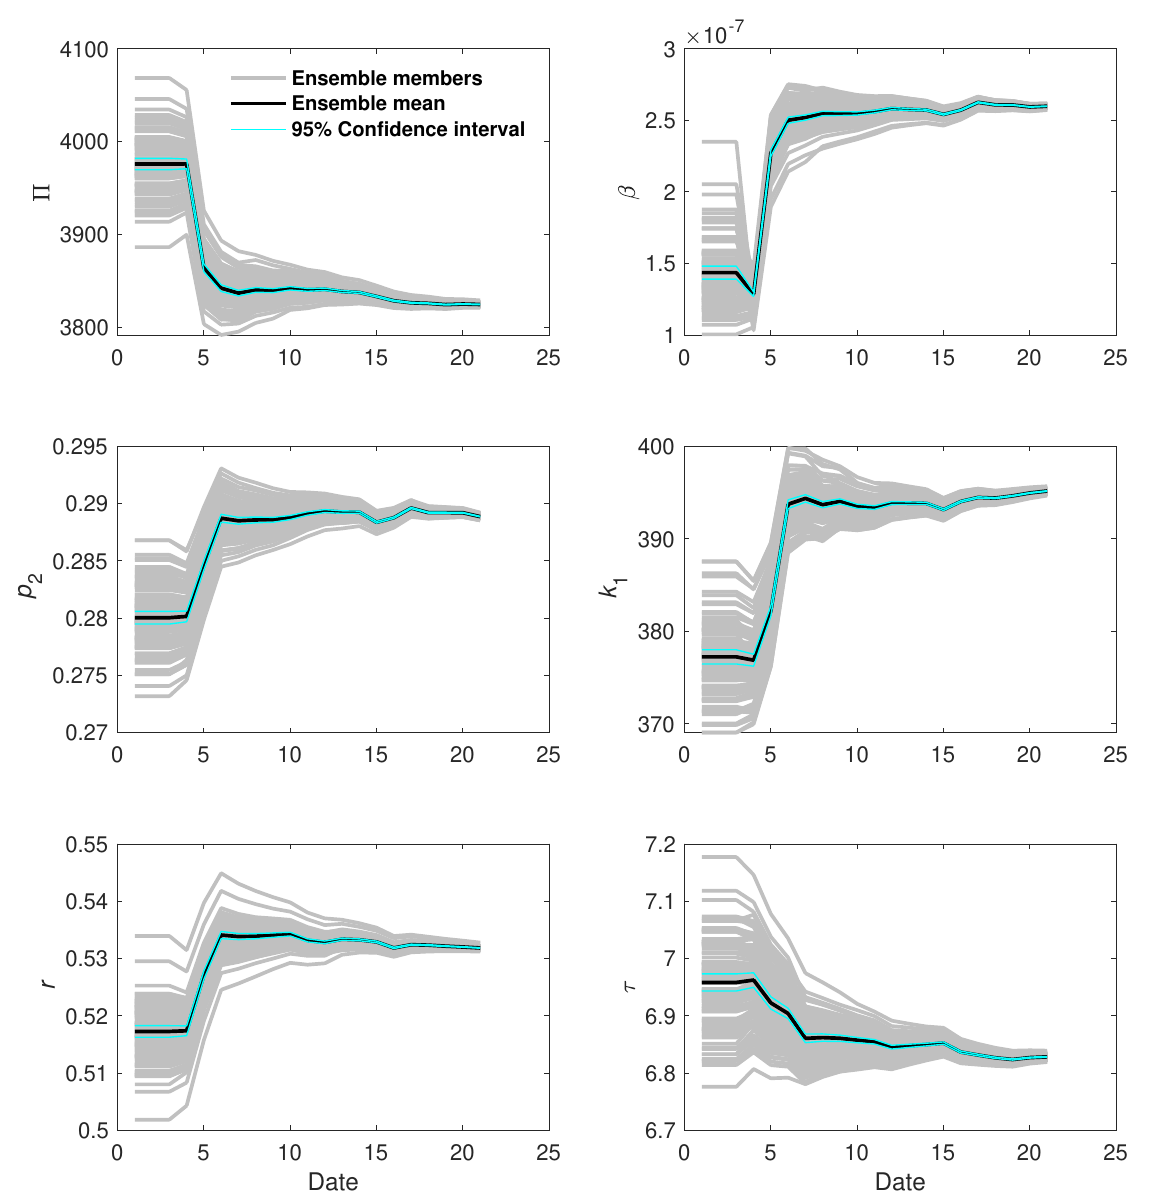
Figure 4. Time evolution of selected parameters estimated by the joint-EnKF for Patient